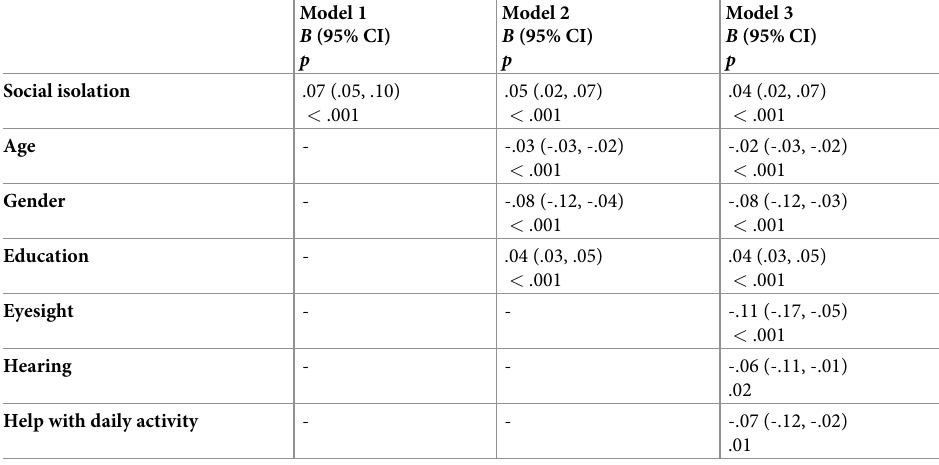
Table 2. Cross sectional association between social isolation and